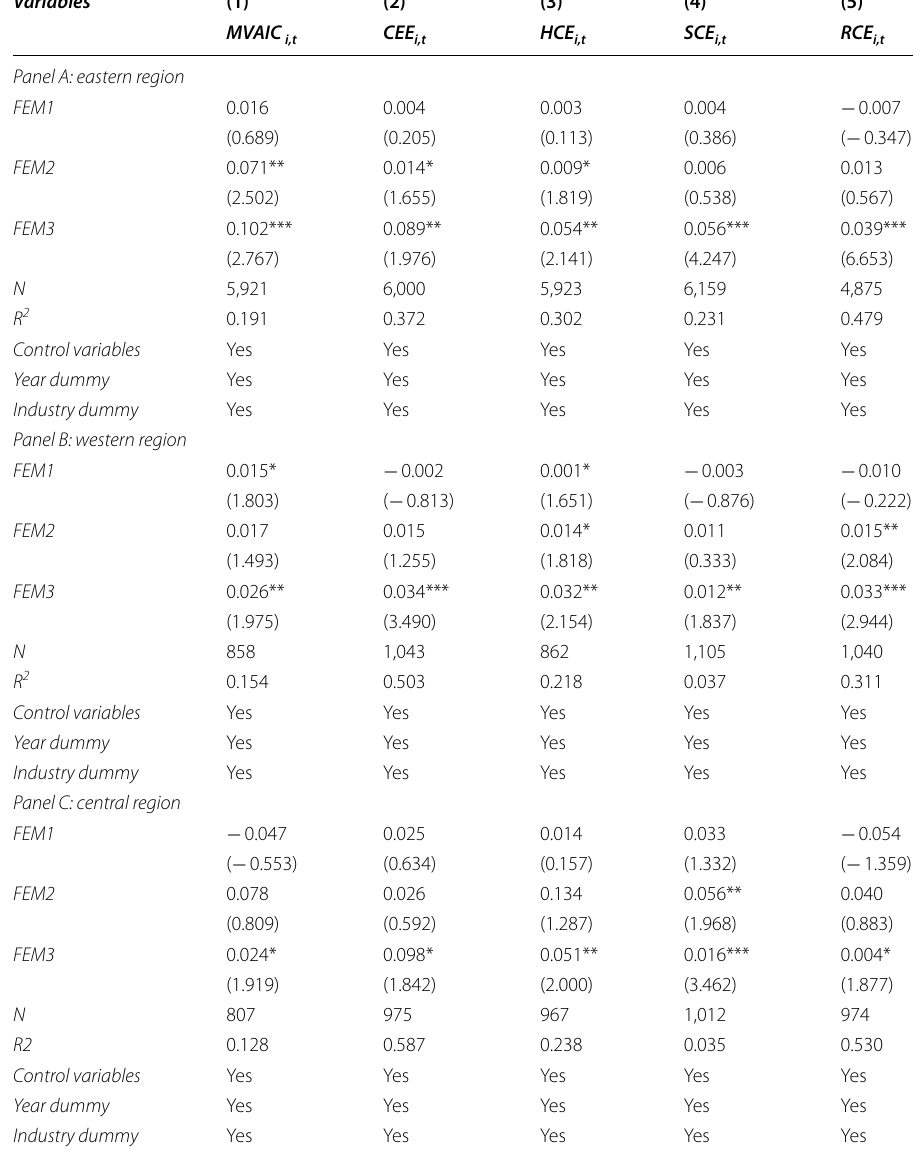
The t-values are given in parentheses. ***, **, and *denotes significance at 1%, 5%, and 10%, respectively. Variable definitions are provided in Table 1